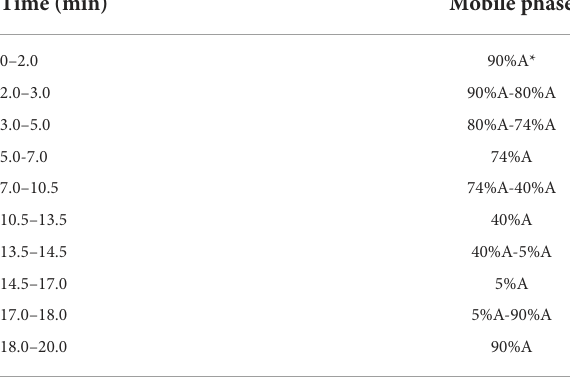
TABLE 1 The gradient elution procedure of